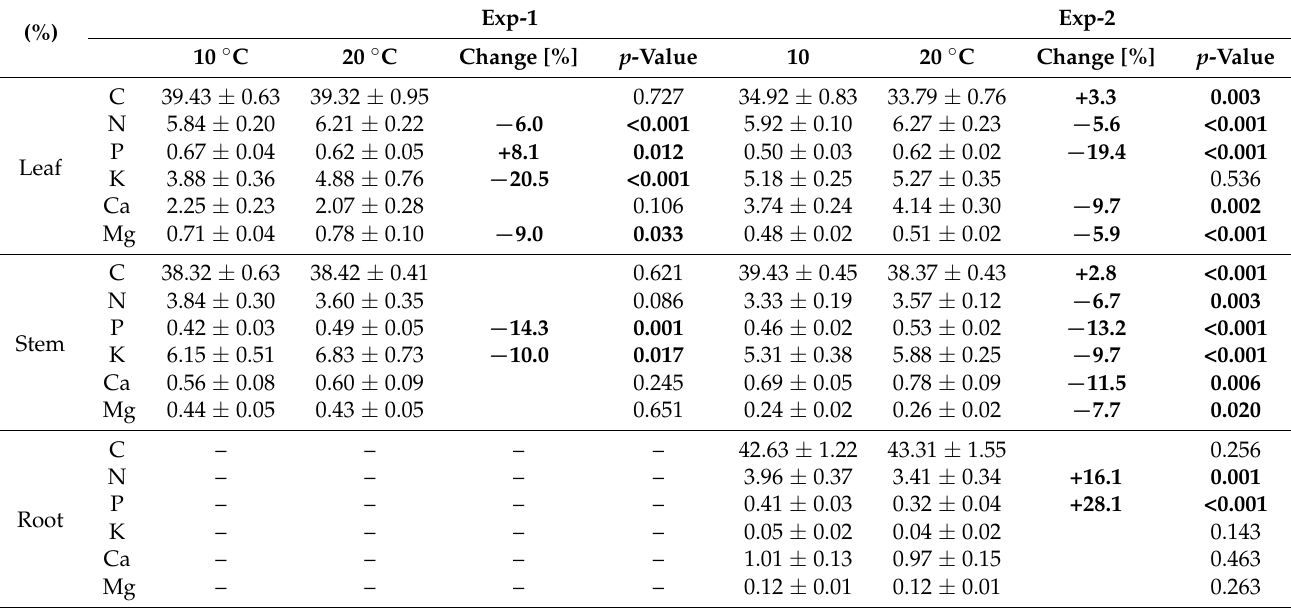
Table 5. Element concentration (% DW) of leaves, stems and roots of Chinese broccoli from different root temperatures and harvest dates in Exp-1 and Exp-2. Significant differences ( p < 0.05) were indicated in bold. DW: dry